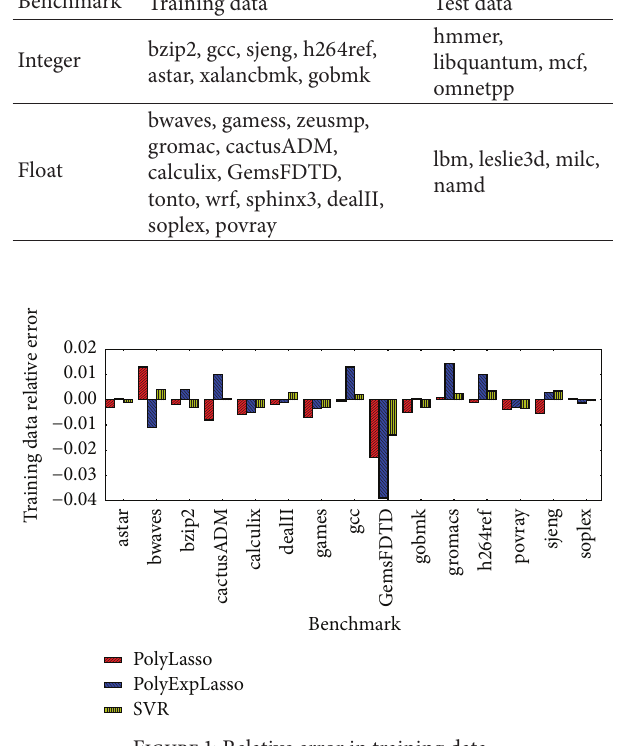
Figure 1: Relative error in training